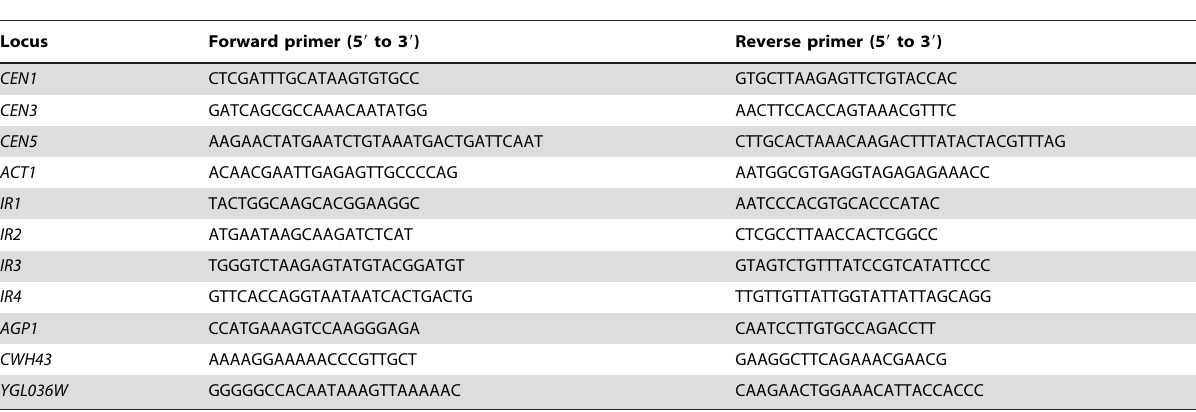
Table 3. List of primers used in this study.